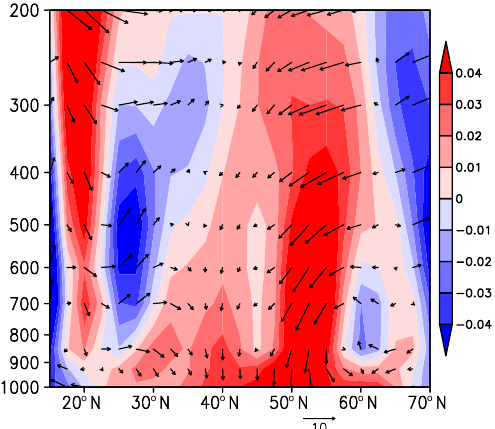
Figure 7. Vertical-latitude section (110–120 ◦ E mean) of wind dur- ing 16–21 December 2016: omega (shading) and wind (arrow, omega was magnified 100